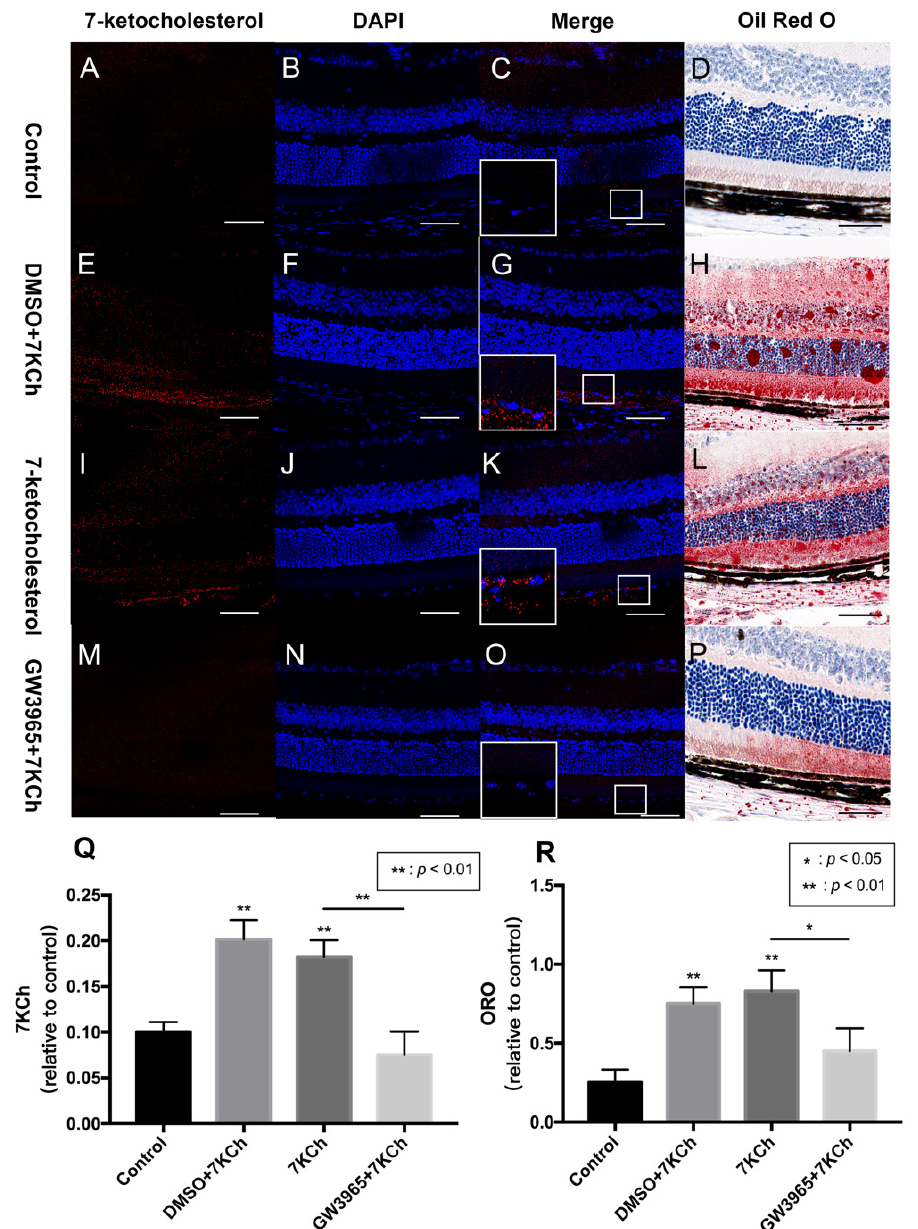
Figure 2. 7KCh immunofluorescence and Oil Red O staining of retinas. 7KCh deposition was detected by immunofluorescence ( A – C , E – G , I – K , M – O ) and Oil Red O staining ( D , H , L , P ). ( A – D ) C57BL/6 mice were gavaged saline (100 µ L/10 g) for seven days ( n = 4). ( E – H ) Firstly, C57BL/6 mice were gavaged DMSO (1%) for three days, and then mice were subretinally injected 7KCh. After injection, gavaging with DMSO (1%) continued for four days. ( I – L ) C57BL/6 mice were gavaged saline (100 µ L/10 g) for three days, then subretinally injected 7KCh. After injection, gavaging with saline (100 µ L/10 g) continued for four days. ( M – P ) C57BL/6 mice were gavaged GW3965 (10 mg/kg) for three days, then the mice were subretinally injected 7KCh. After injection, gavaging with GW3965 (10 mg/kg) continued for four days. Retinas were harvested, sectioned, and subjected to double immunofluores- cent staining and Oil Red O staining analyses. Scale bar 50 µ m. ( Q , R ) 7KCh immunofluorescence and Oil Red O intensity were averaged at eight locations. Data are represented as mean ± SEM of three independent experiments. Differences of p < 0.05 were considered statistically